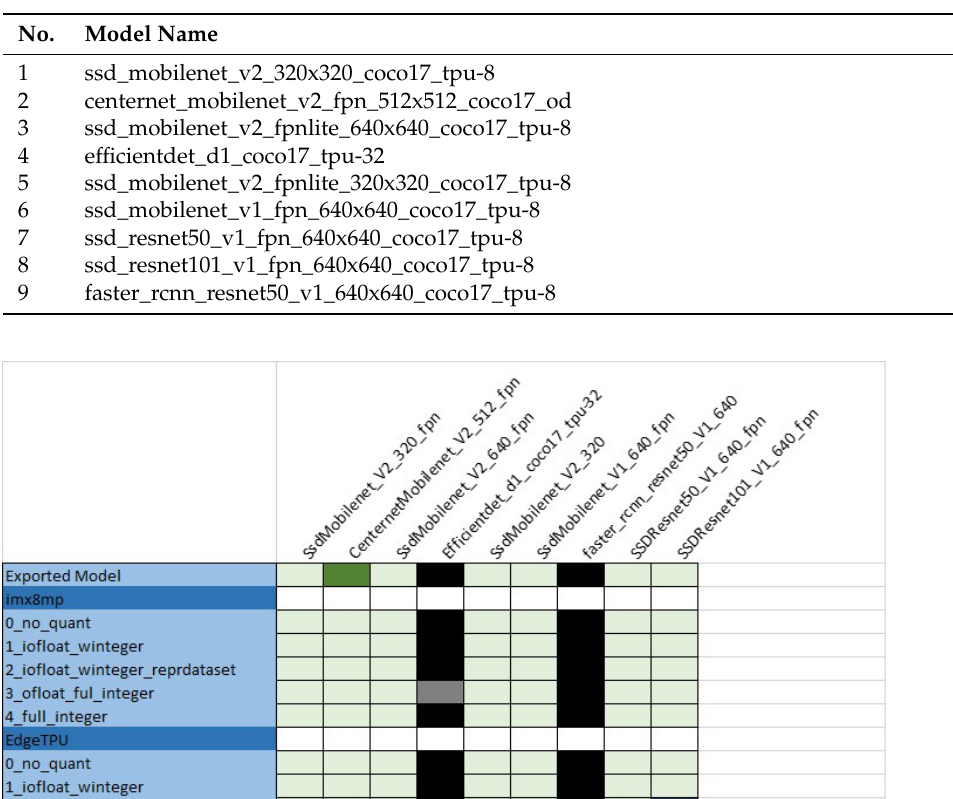
Figure 5. DL model conversion workflow using TensorFlow and TensorFlow Lite. Table 2. Models used in the hardware benchmark.